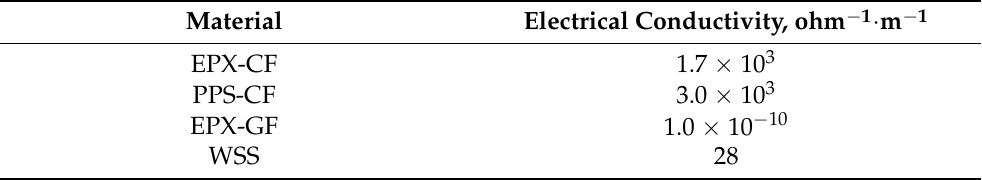
Table 1. Electrical conductivity of the FRP composites and the liquid water-based saline solution (WSS) in which they were immersed.